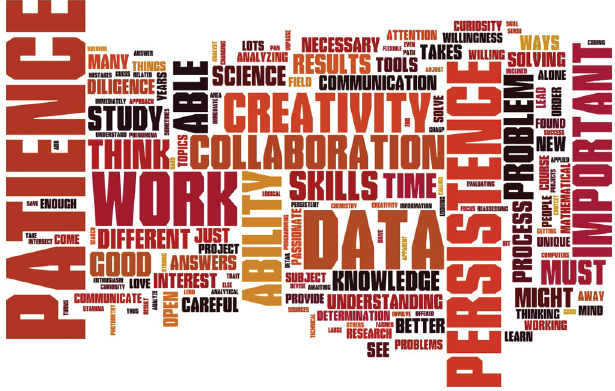
FIG. 2. Qualities of an astronomer. Words that have prominence in this word cloud include patience, persistence, creativity, and